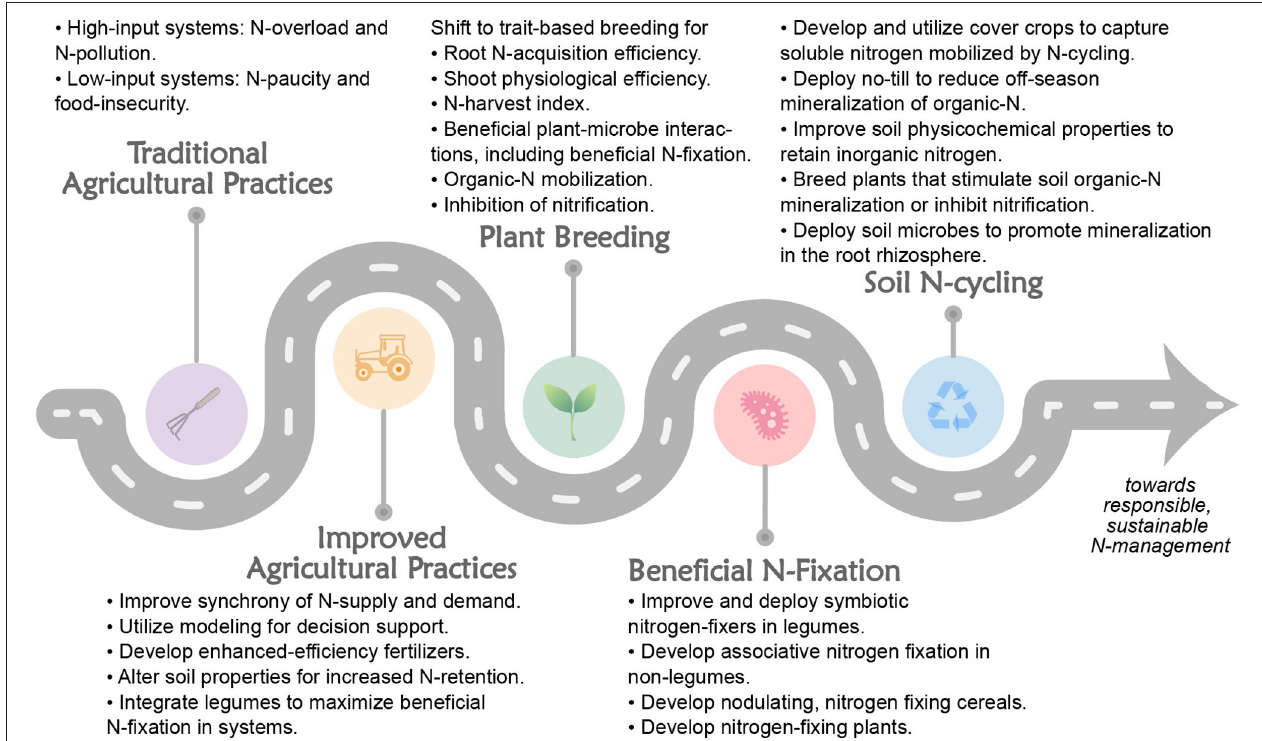
FIGURE 2 | We propose a systematic roadmap for improving NUE using improved agronomy (i.e., agricultural practices), plant breeding, biological N fixation, and controlled soil N cycling.